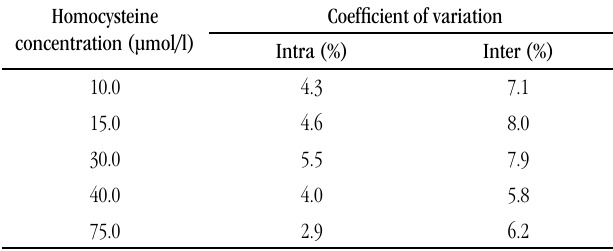
Relative standard deviation intra-assay ( n = 5) and inter-assay ( n = 3 days; n = 5 replicates). HPLC: high-performance liquid